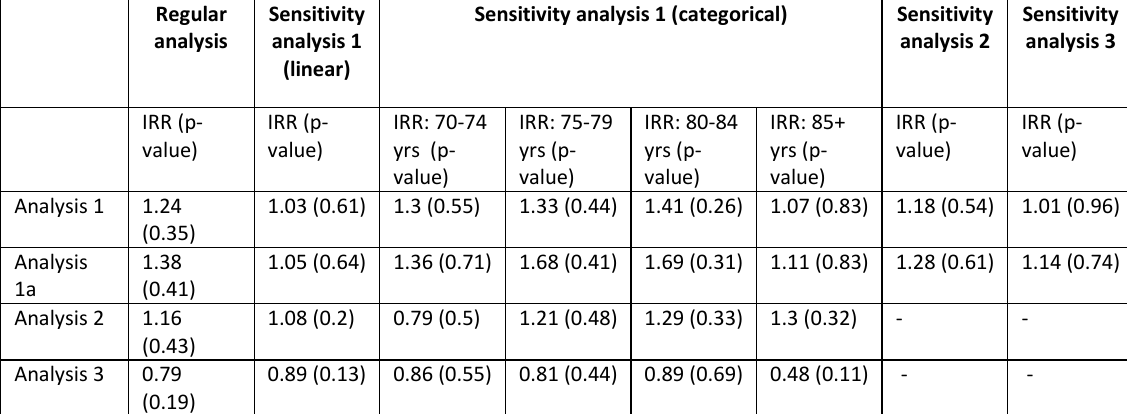
Table S2: IRRs and corresponding p-values resulting from the sensitivity analyses.